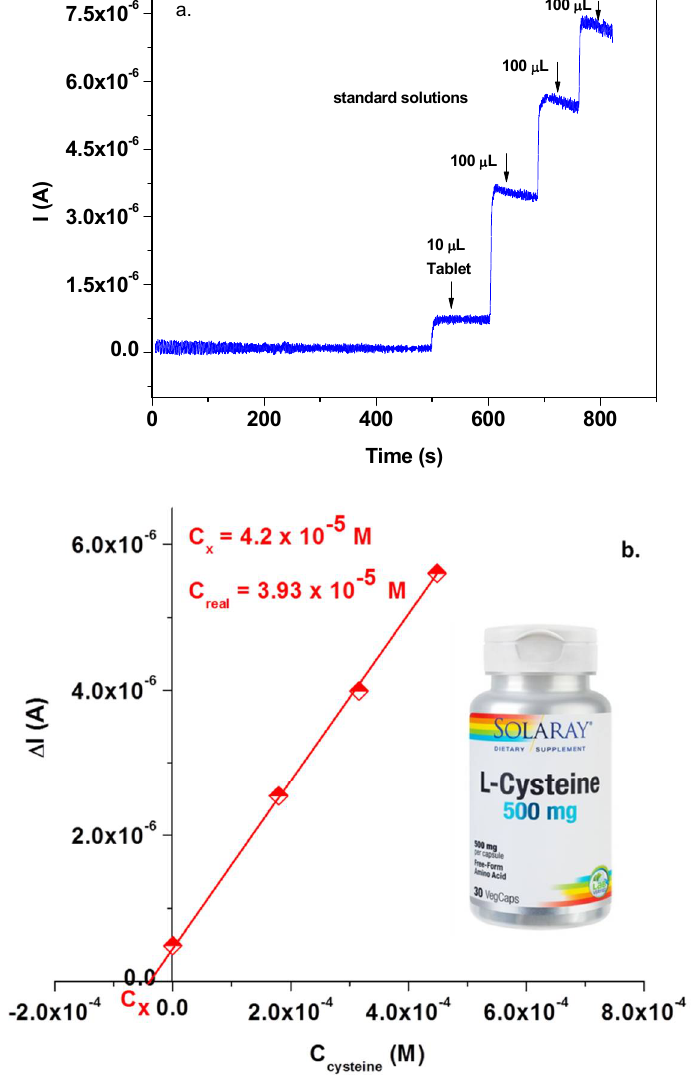
Figure 12. The amperogram recorded during standard addition experiment at a potential of +0.62 V ( a ); standard addition plot obtained from the amperogram ( b ).